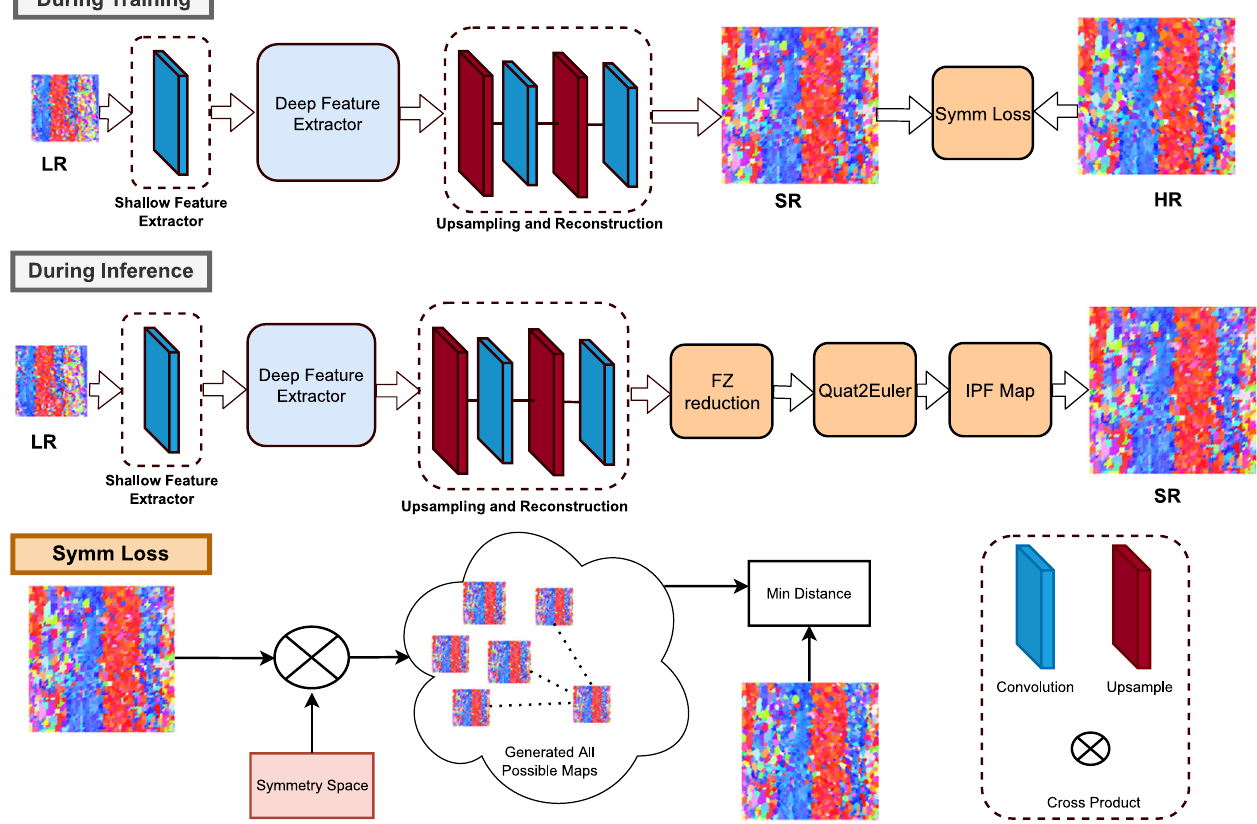
Fig. 1 Network architecture. Training pipeline: a low-resolution EBSD map in quaternion orientation space is given to an image super- resolution network architecture that generates a high-resolution EBSD map in quaternion orientation space. A crystallographic symmetry physics-based loss with L 1 or approximate rotational distance is used during training. Inference pipeline: the image super-resolution network generates a high-resolution EBSD map in quaternion orientation space, which is reduced to a fundamental zone space, and converted to Euler orientation space to visualize in IPF color map. Symmetry loss: takes all possible hexagonal symmetries for the titanium alloy, and computes the minimum distance between all possible generated output and ground truths. The distance can be L 1 or approximate rotational